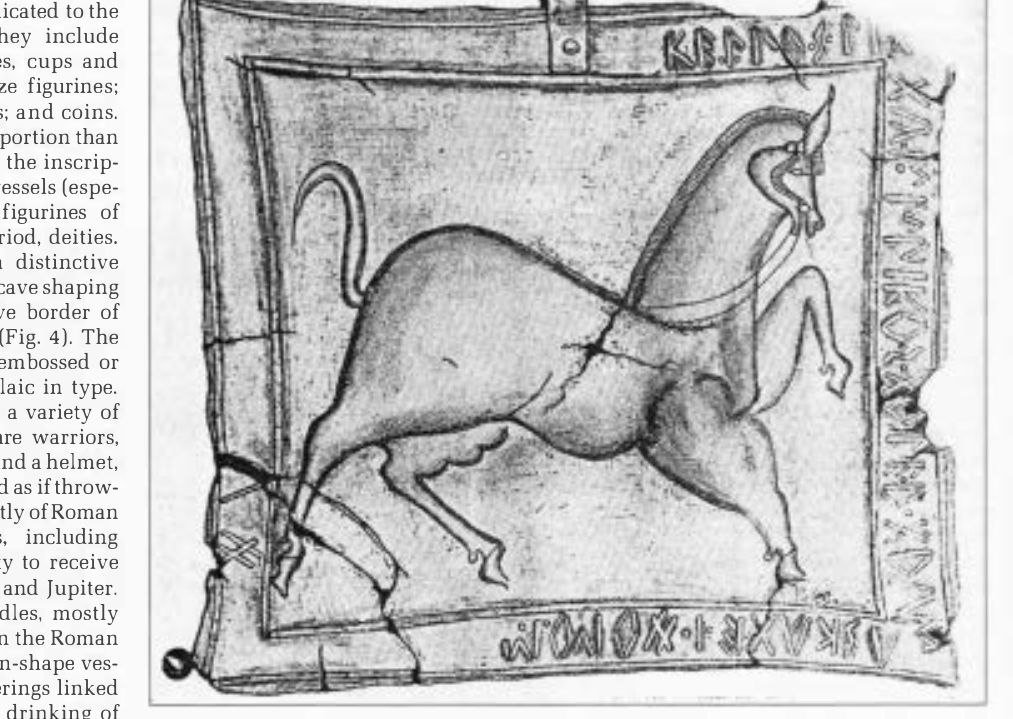
Figure 4 Bronze votive plaque (19x17cm) from Lagole, with an embossed figure of a horse and an inscription around the edge reading Kellos Pittamnikos toler